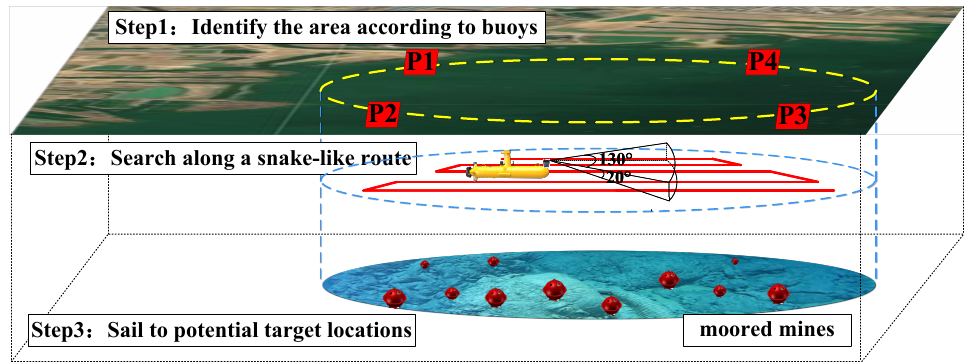
Figure 1. Schematic diagram of a target search